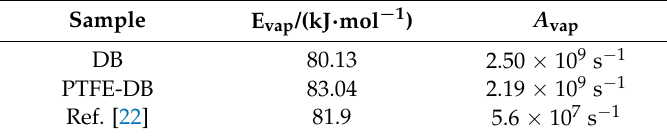
Table 3. Evaporation kinetics of NG in the two